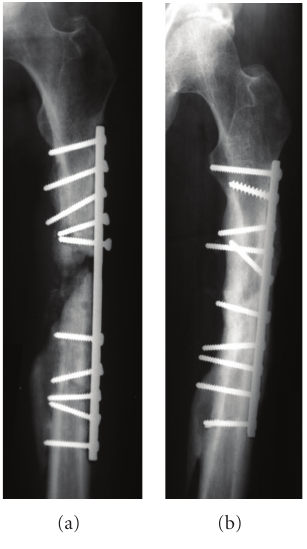
Figure 5: Reconstruction of a femoral bone defect with BCP. X-Ray images of a femur before (a) and after (b) reconstruction with the BCP and stabilized with internal fixation system, after